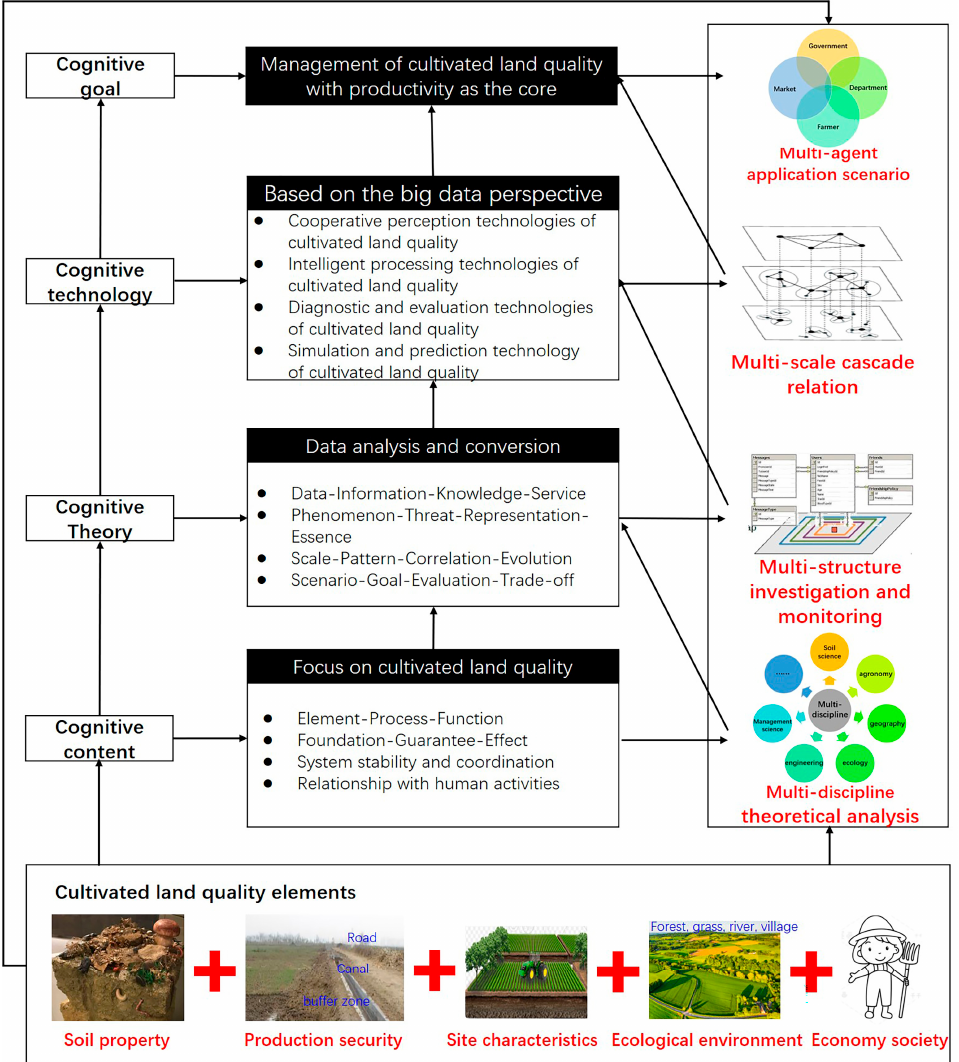
Figure 3. Technical System of Systematic Understanding and Analysis of Cultivated Land Quality. The picture below represents the different components of cultivated land quality. The content of cognitive content, cognitive theory, cognitive technology, and cognitive goal on the left corresponds to the middle block diagram, and the relationship corresponds to the picture on the right.